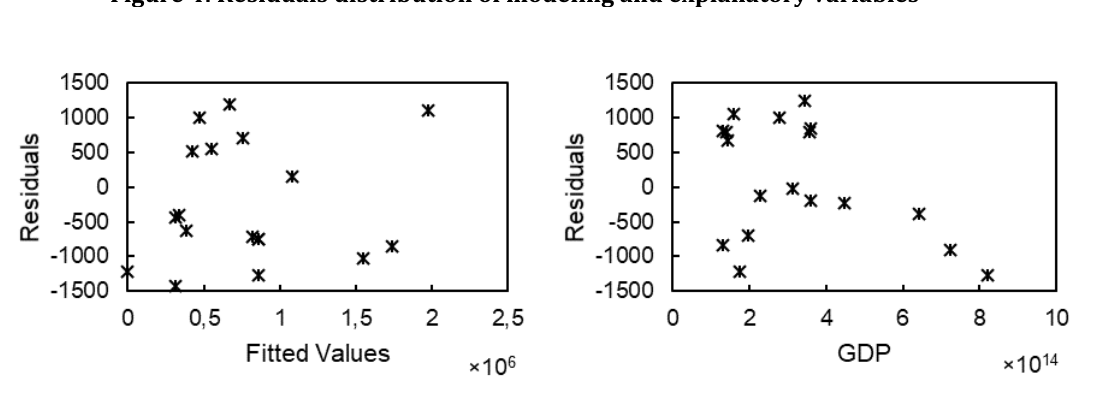
Figure 4: Residuals distribution of modeling and explanatory